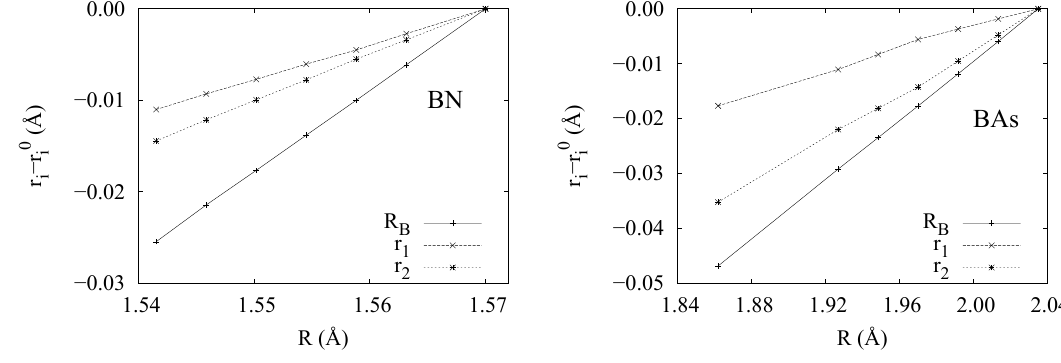
Figur e 5. Evolution of the geometrical parameters, r interatomic distance R for BN ( left ) and BAs ( right ). Data relative to the corresponding equilibrium values denoted by a 0 superscript. All numbers in